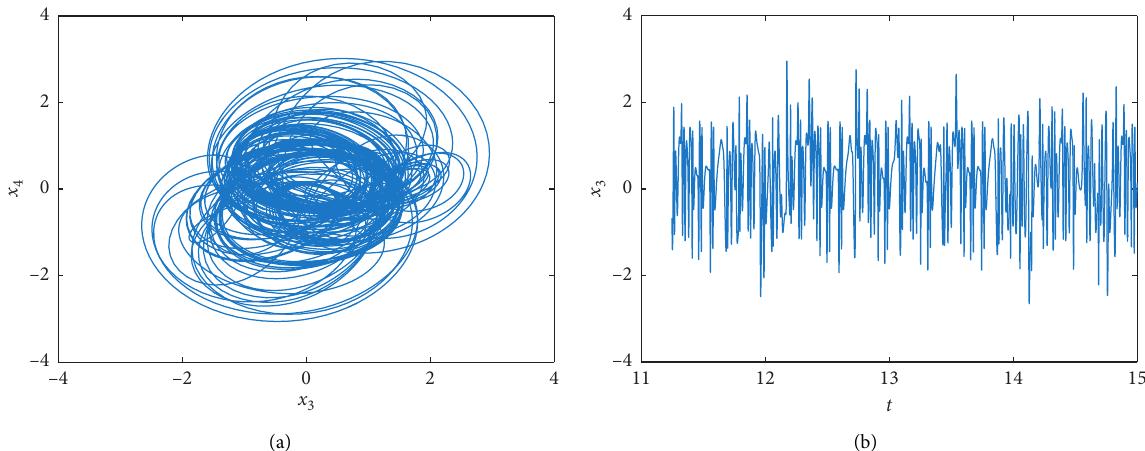
Figure 12: Phase portrait on plane ( x motion when P